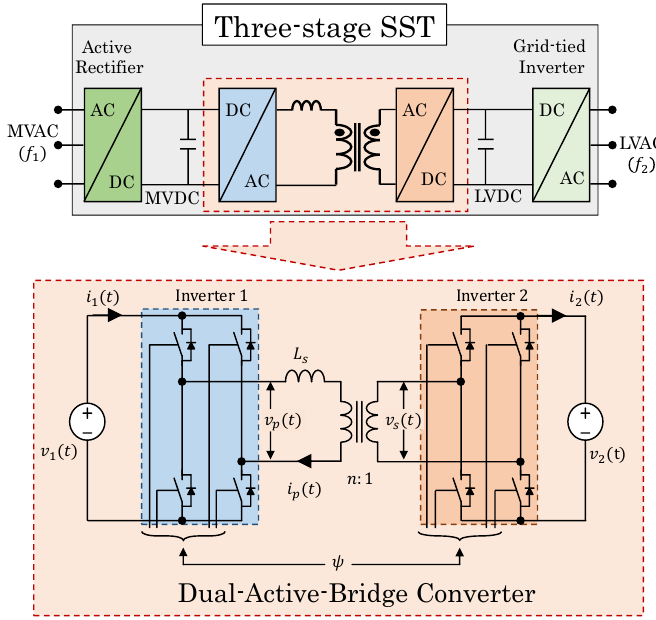
Figure 1. Three-stage Solid State Transformer